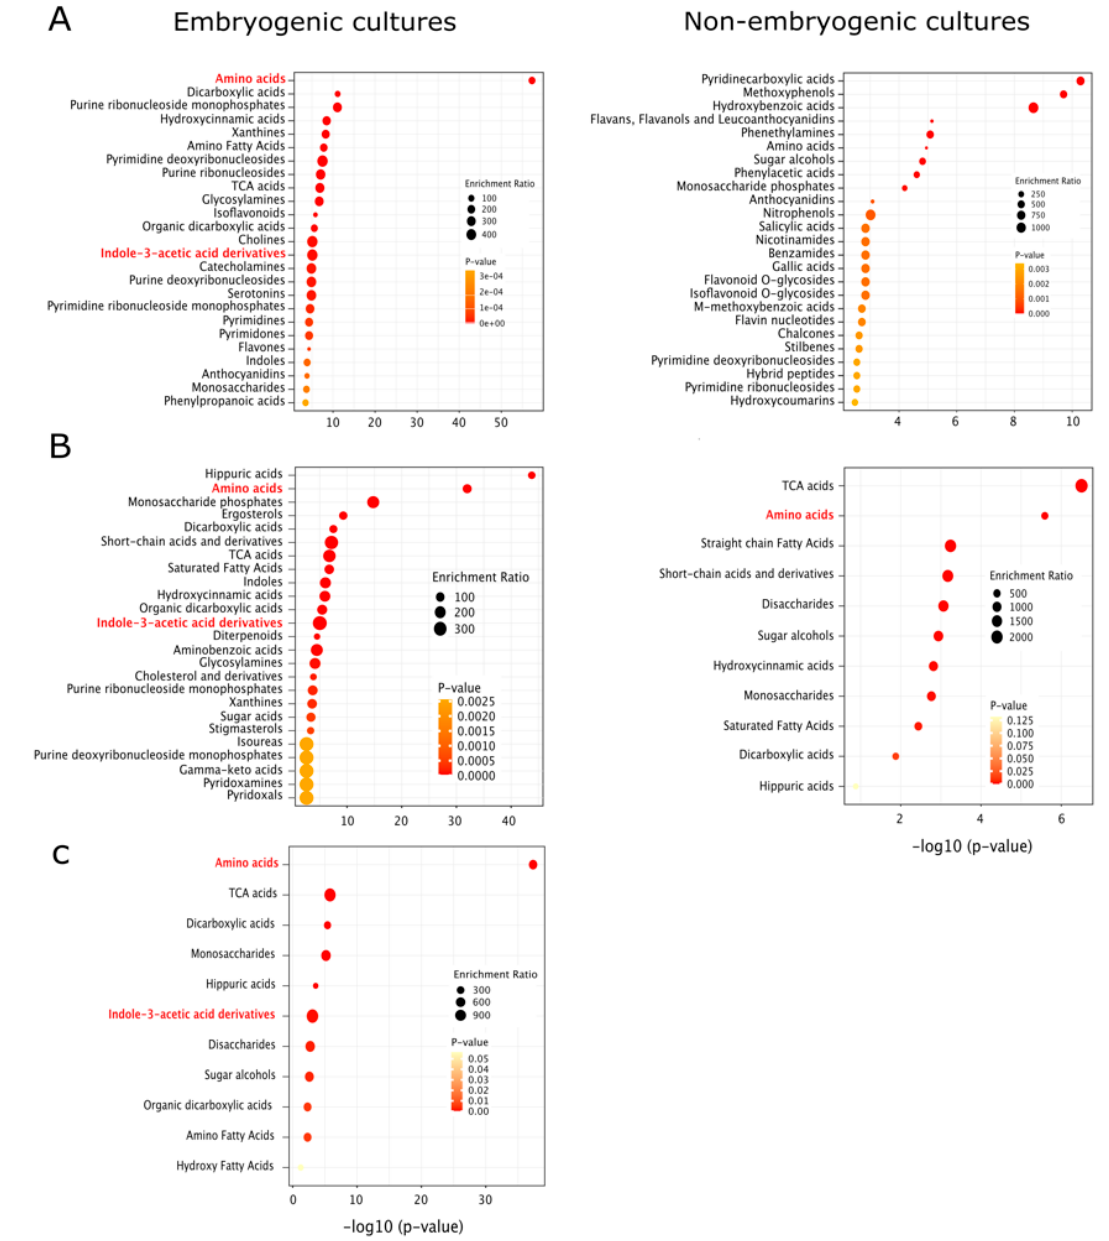
Figure 3. Enrichment analysis of available metabolomics data in EC and NEC in dicots ( A ), monocots ( B ) and gymnosperms ( C ). We computed KEGG annotations in metaboanalyst 5.0 bioinformatic platform (https://www.metaboanalyst.ca/, accessed on 27 September 2021). We used the library of 1072 sub chemical class metabolite sets.